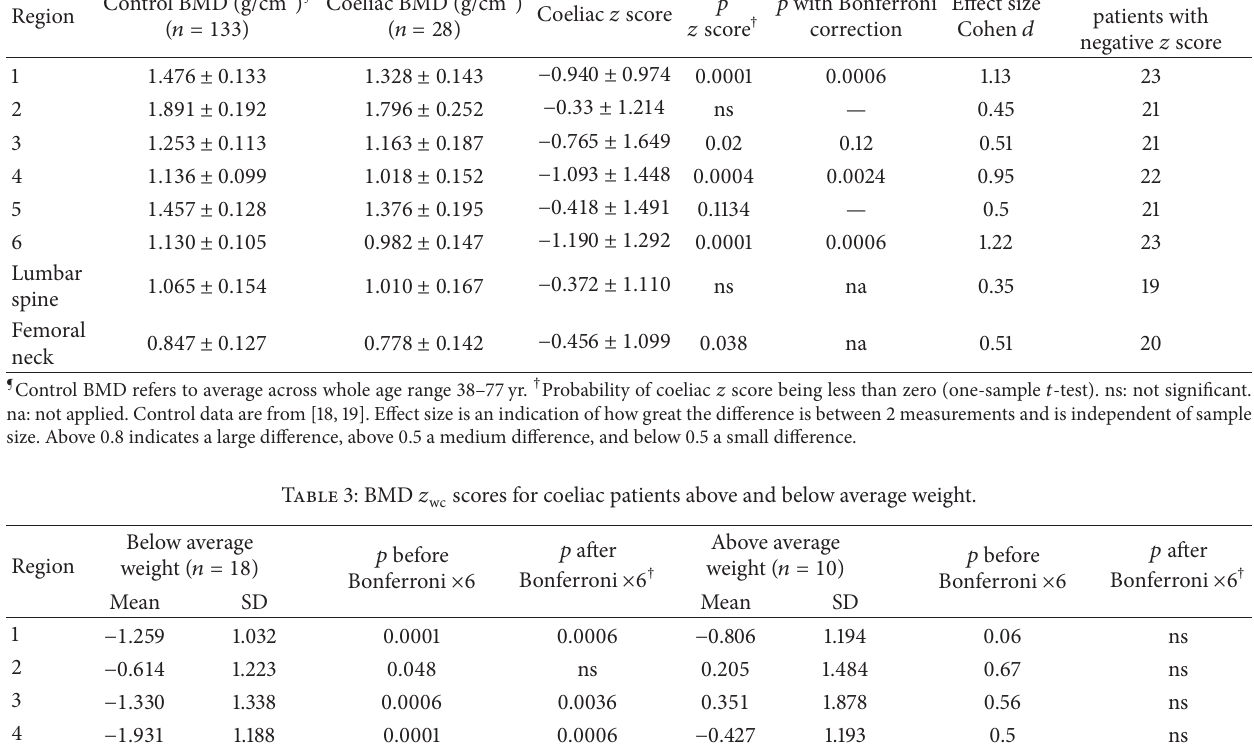
Table 2: Bone mineral density in the lower limb regions, spine, and femoral neck in patients with coeliac disease compared with controls. Region